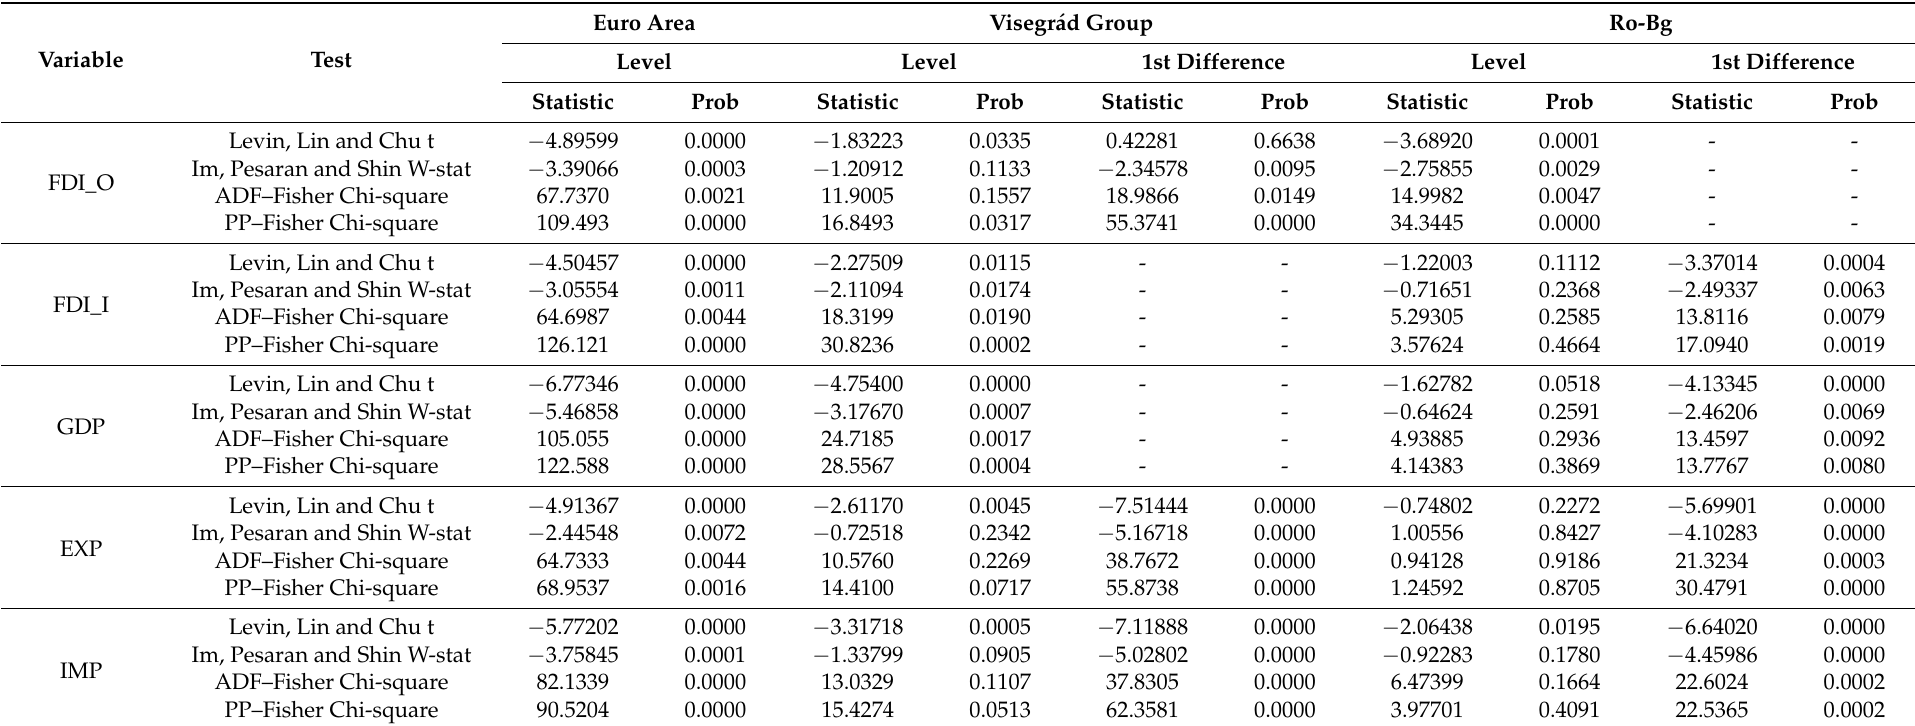
Table 1. Unit root